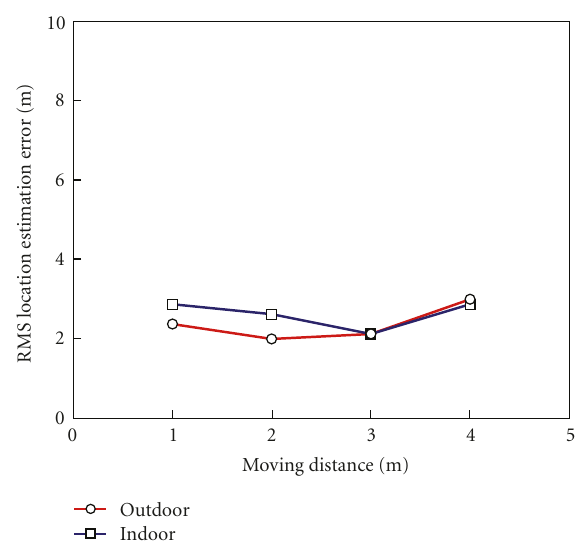
Figure 19: Experimental result on the RMS location estimation error.